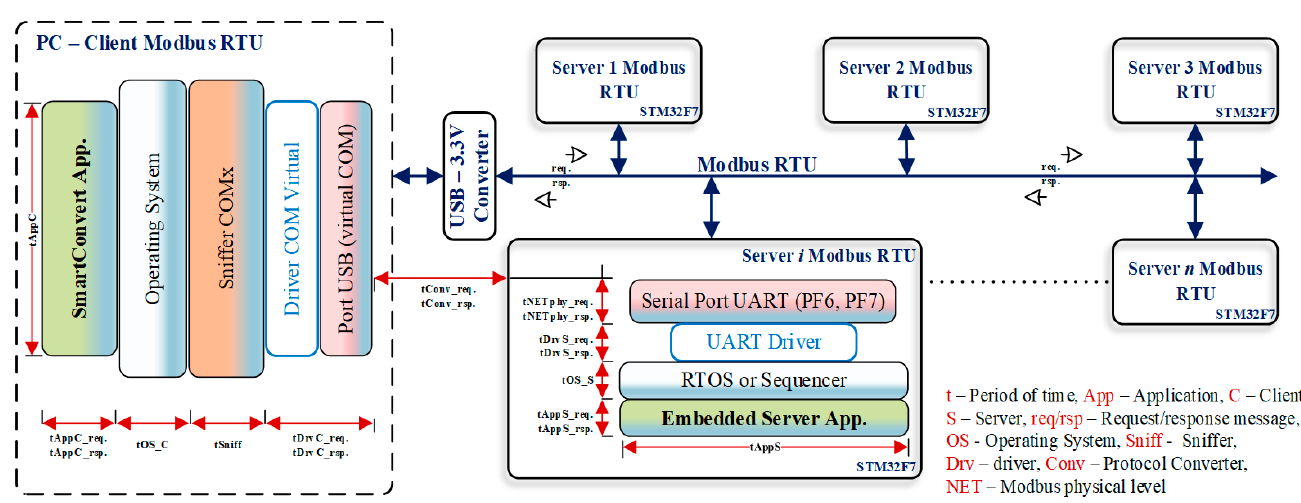
Figure 2. Experimental architecture of the Modbus client–server system.